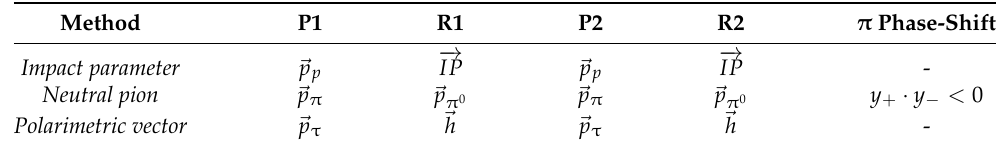
Table 1. Summary of the vectors used in the presented notation to reconstruct the acoplanarity angle in order to reproduce the methods described in Section 3. The last column shows the condition for which it is preferable to apply a phase shift of π . A-symbol is used to mark methods which do not require such a phase shift, while the y ± definition can be found in Equation